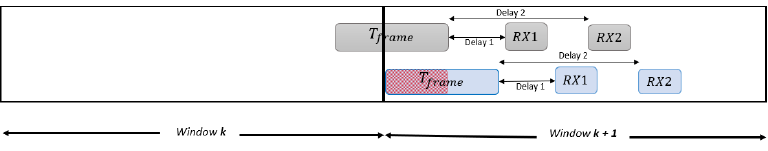
Figure 6. Border effect between time